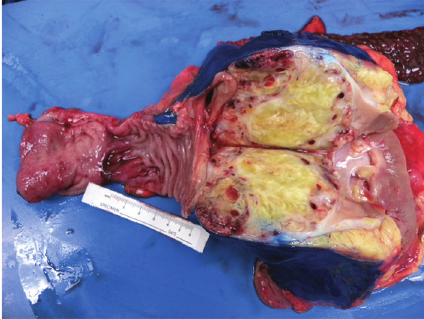
Figure 3: Right renal mass invading the duodenum. Ruler demon- strates length of duodenal invasion.